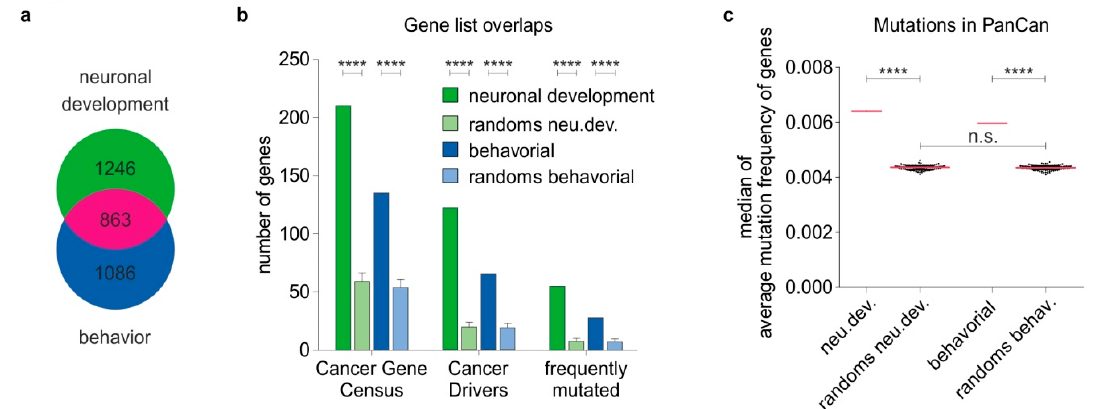
Figure 1. Nervous system-related genes undergo frequent gene mutations across cancer types. ( a ) Nervous system-related genes were defined as genes where the knockout of which in mice leads to abnormal phenotypes of neuronal development or behavior/neurological function. ( b ) Left: a significant enrichment of Cancer Gene Census factors was observed among the nervous system-related genes relative to the random control lists. Middle: the same analysis in a group of 127 significantly mutated genes which have been identified as oncogenesis drivers across 12 major cancer types, whereby most tumors bear two to six of these mutations [19]. Right: the same tendency was observed when nervous system-related genes were juxtaposed to a list of 299 driver genes and mutations identified from a comprehensive PanCancer and PanSoftware analysis spanning 9423 tumor exomes and using 26 computational tools [20]. ( c ) The median over all genes of the list of the average mutation frequency of nervous system-related genes is significantly higher in the PanCan cohort versus genes of the random lists. This entails a higher number of patients exhibiting mutations in nervous system-related genes. Z-test was used for statistical analyses; **** p < 0.0001, n.s.: non- significant.